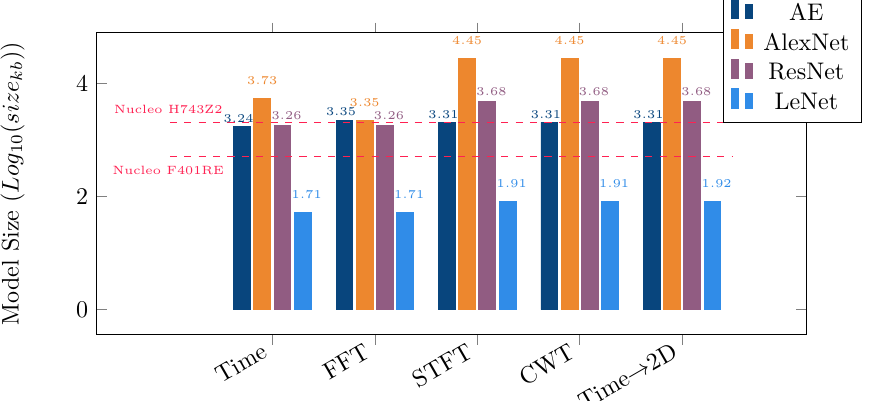
Figure 8. Comparison of required memory size of AE, AlexNet, ResNet and LeNet for different feature sets.